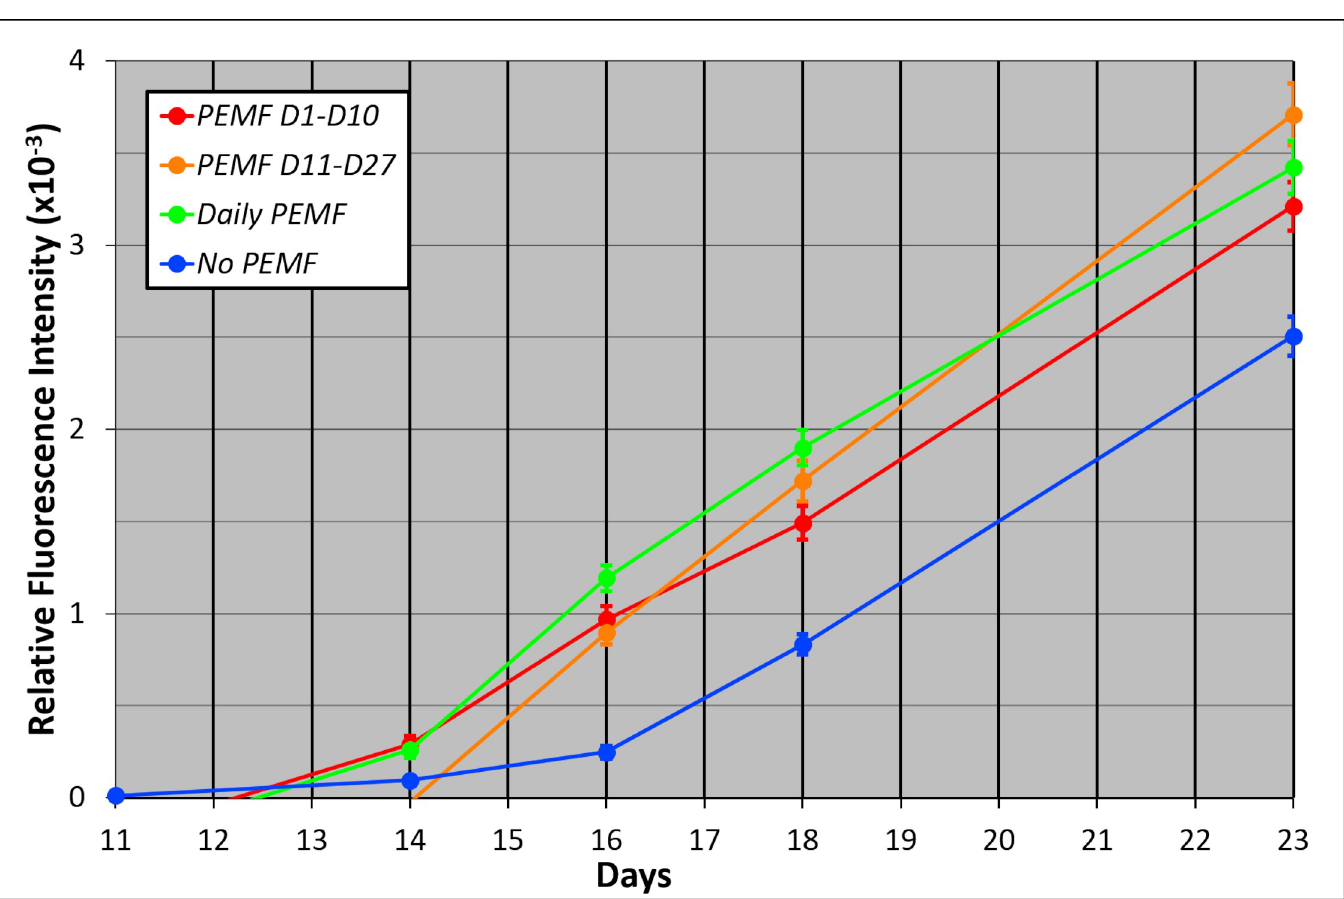
Fig 5. Comparison of early PEMF-induced ARS mineralization responses for Protocol A, B, and D. Data have been combined from Fig 4A, 4B and 4D in this emphasized narrow time frame. P-values for comparison to no-PEMF controls were uniformly less than 0.01 and can be found in Fig 4 but have been removed here for visual clarity. Fold increase compared to no-PEMF controls at Day 16 were 3.91, 3.61, and 4.81 for PEMF at D1-D10, D11-27, and Daily, respectively.